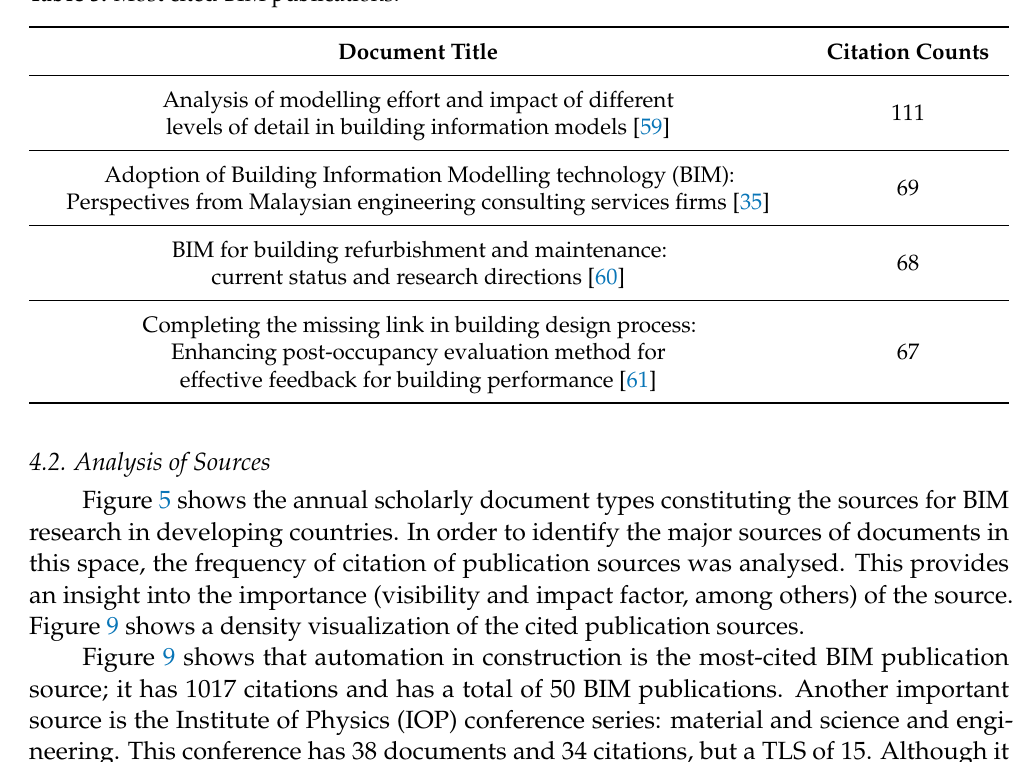
Table 3. Most cited BIM publications.